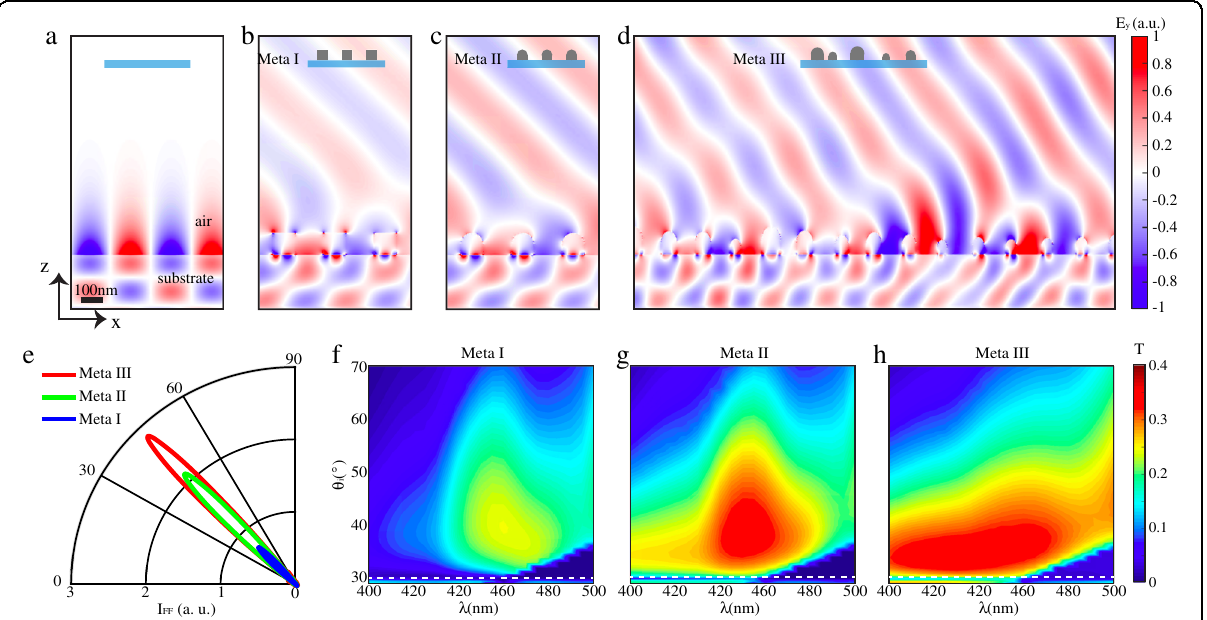
Fig. 2 FDTD simulations for the evolution-inspired light extraction. a The fi eld distribution E y of a substrate without any light extracting structures. When the incident light is beyond critical angle, no photons can escape. b – d The fi eld distribution E y of a substrate with ( b ) Meta-I, ( c ) Meta-II and ( d ) Meta-III. The amplitude of the electric fi eld coupled outside is gradually increased, demonstrating the improvement of light extraction by utilising the bio-inspired features. e , A far- fi eld intensity for three different metasurfaces. For simulations in ( a – d ), the incident angle is chosen as θ = 32 o while the critical angle for TIR is θ = 30 o . The wavelength of the light is at 450 nm. f – h The transition spectra of the substrate at different i c incident angles beyond θ c ; ( f ) Meta-I, ( g ) Meta-II and ( h ) Meta-III. For disordered Meta-III, 3 samples with different sets of random variables are investigated. The white dashed line corresponds to θ c . A prominent improvement is observed for different angles and wavelength from Meta-I to Meta-II. The region with ef fi cient light extraction (reddish colour) is enlarged by the introduction of disorder